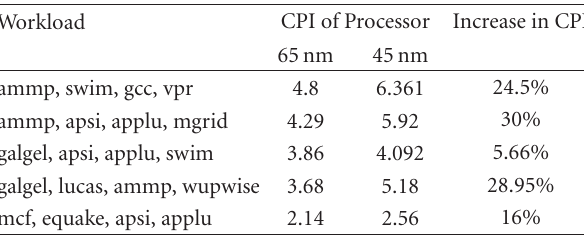
Figure 15: Factors behind Performance Improvement Shown in Figure 14(c). Table 3: Comparison of CPI between baseline processors modeled after di ff erent technology